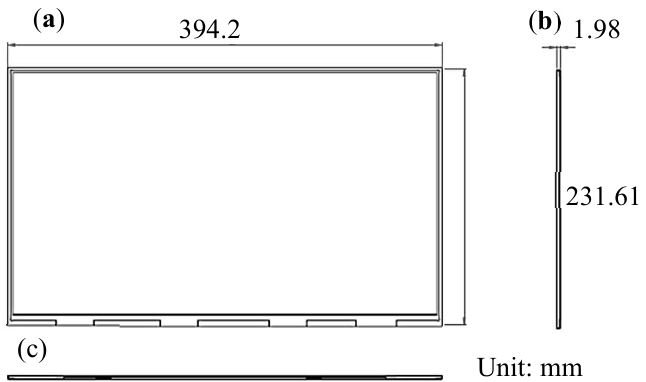
Figure 18. Three-view drawing of 17 in extra-thin, large-area, high-luminance surface light source module: ( a ) top view; ( b ) side view; ( c ) front view.